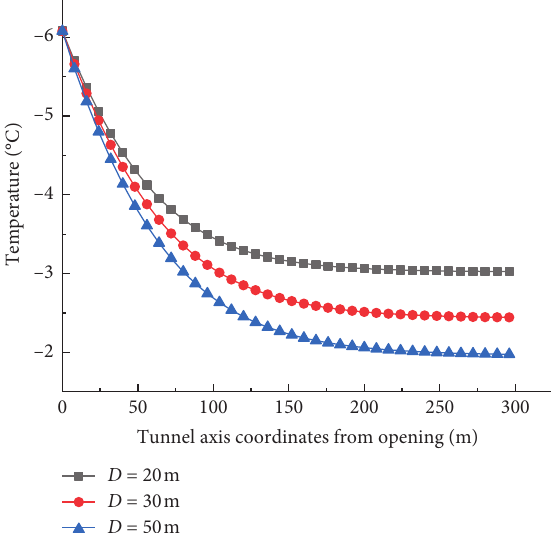
Figure 28: Distribution characteristics of the annual average air temperature in the tunnel axis under different depths.